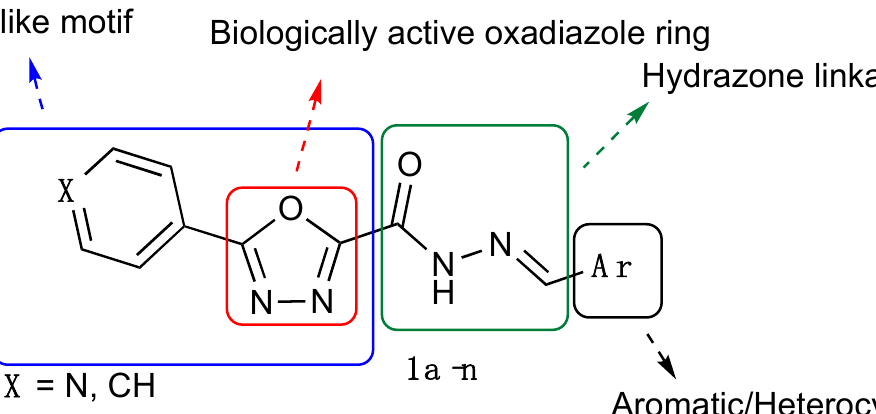
Figure 1. Structure and rationale of new 1,3,4-oxadiazole containing derivatives 1a–n .